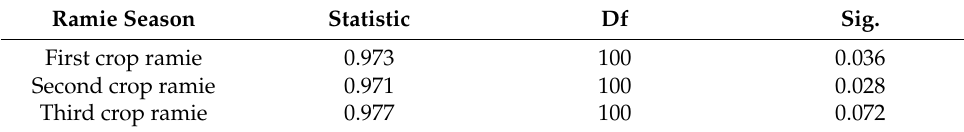
Table 3. Result of Shapiro–Wilk